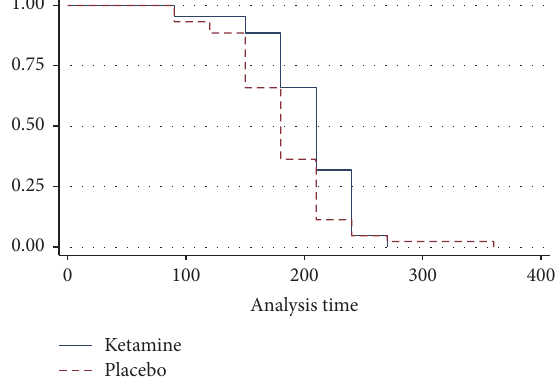
Figure 4: Kaplan-Meier survival curve. Ketamine versus placebo Kaplan-Meier survival estimates for breakthrough